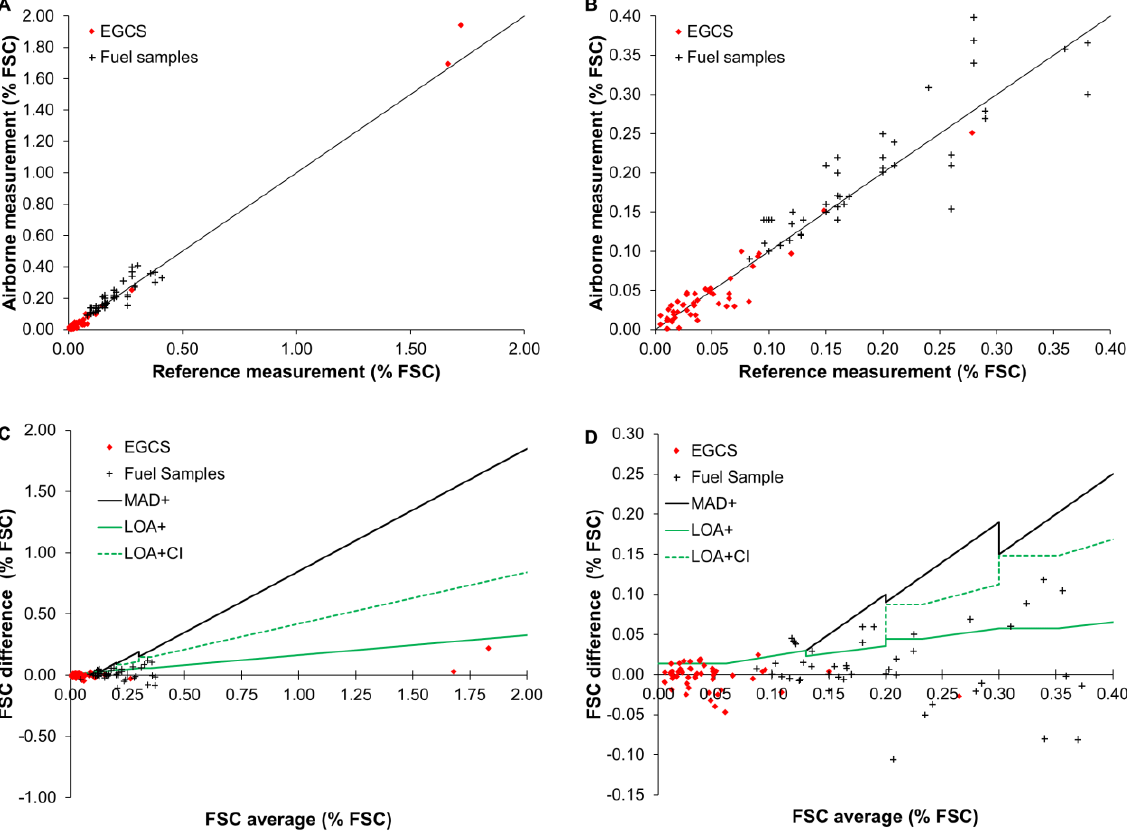
Figure 4. Comparison of reference data from EGCS (in red ♦ ) and fuel samples (in black +) with the airborne measurement for the full FSC range; the perfect fit is visualized with a black line (x = y) ( A ). Comparison of reference data with airborne measurement for FSC values < 0.4% FSC ( B ). Modified B&A graph comparing the reference values with the airborne measurements for the total FSC range. The Limits of Agreement (LOA) are based on either the standard deviation or the relative standard deviation (the highest of the two applies), the confidence interval is added to the LOA in accordance with the CI as defined by the thresholds (LOA + CI) ( C ). Modified Bland Altman graph comparing the reference values with the airborne measurements for FSC values < 0.4%FSC ( D ).